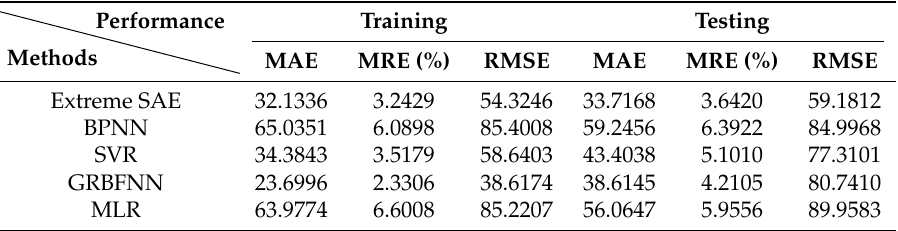
Table 4. Comparison results of the five prediction models in the 60 min prediction